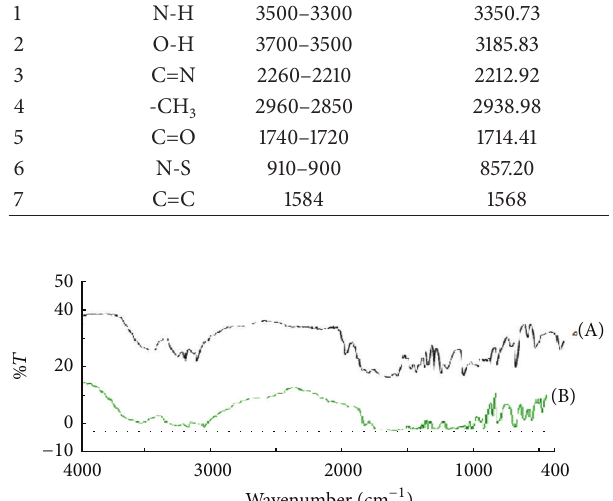
Table 4: FTIR spectrum of timolol maleate. Sr. number